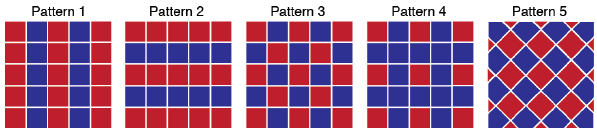
Figure 6. Computational mode patterns for the A, B and E